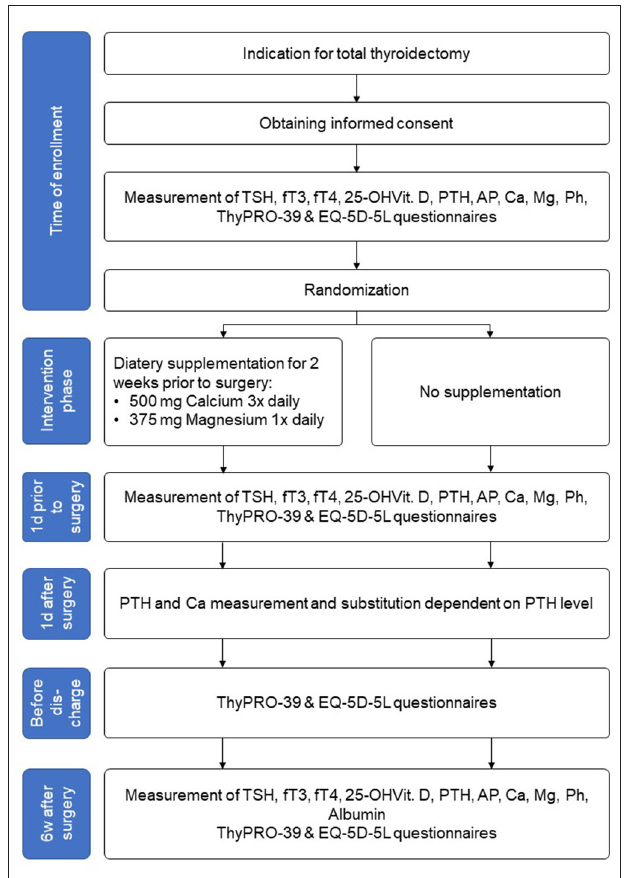
FIGURE 1 | Study flow